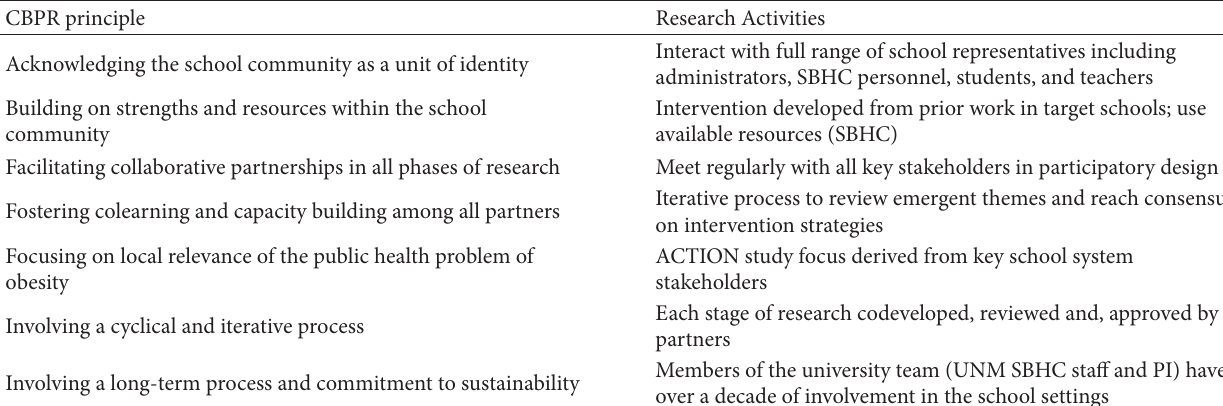
Table 1: Research activities associated with CBPR Principles.